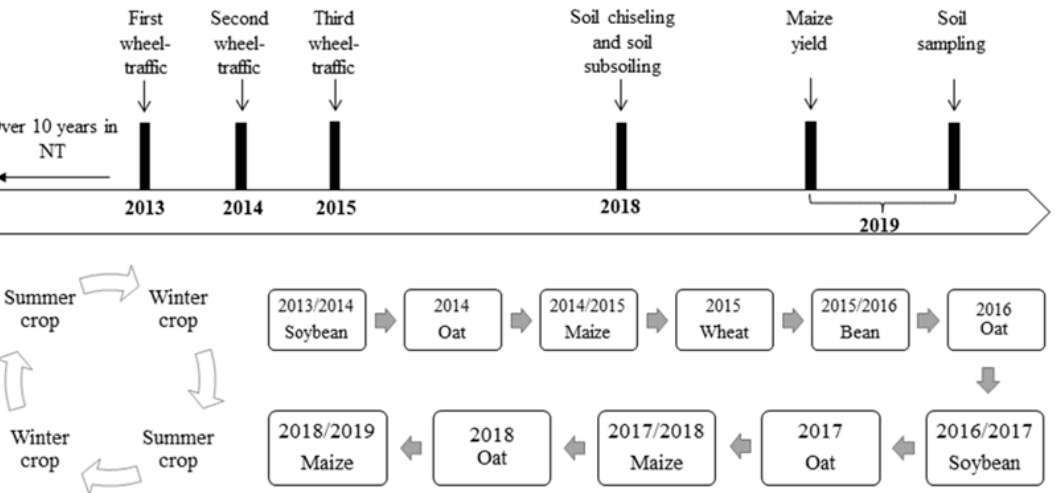
Figure 1. Chronology of the experimental site and management in the experimental area, highlighting the field traffic events, soil mechanical interventions, soil sampling, and the crop cultivation sequence.